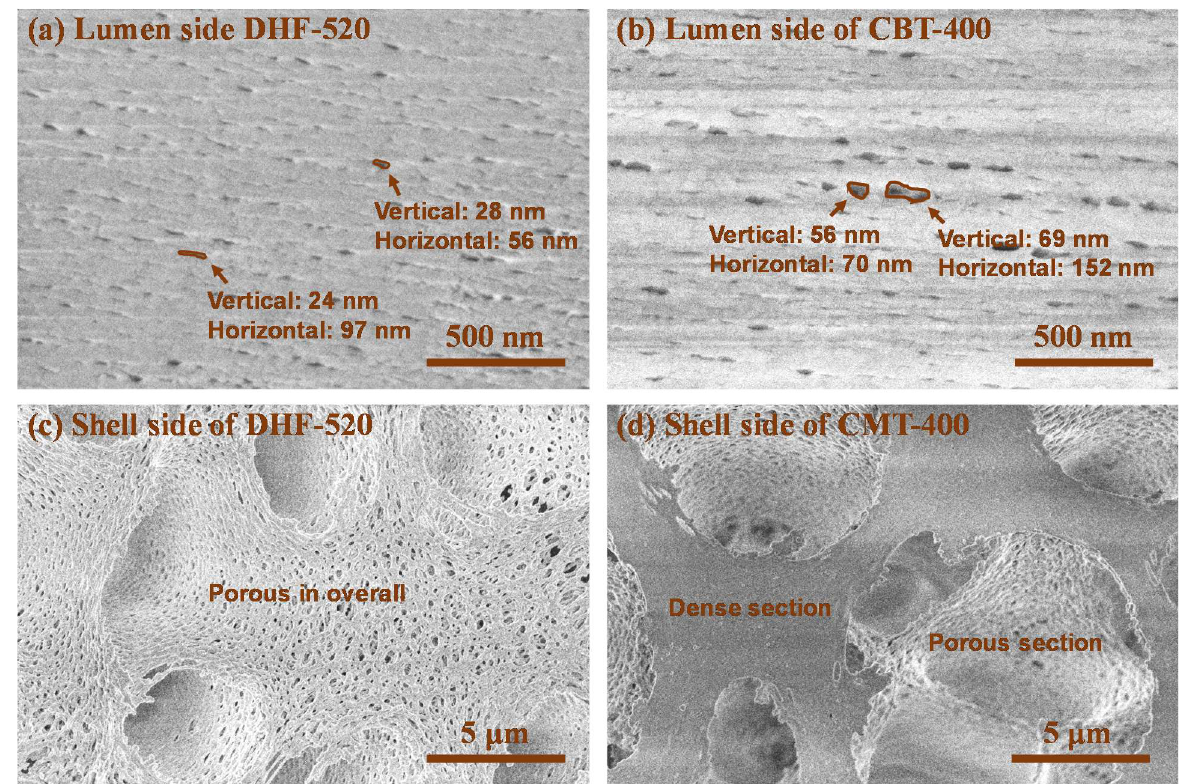
Figure 6. Surface morphology of lumen side and shell side, ( a ). High-magnification top-view SEM image of DHF-520 lumen side, ( b ). High-magnification top-view SEM image of CHF lumen side, ( c ). Shell-side top-view SEM image of DHF-520. Shell-side top-view SEM image of CHF, ( d ).